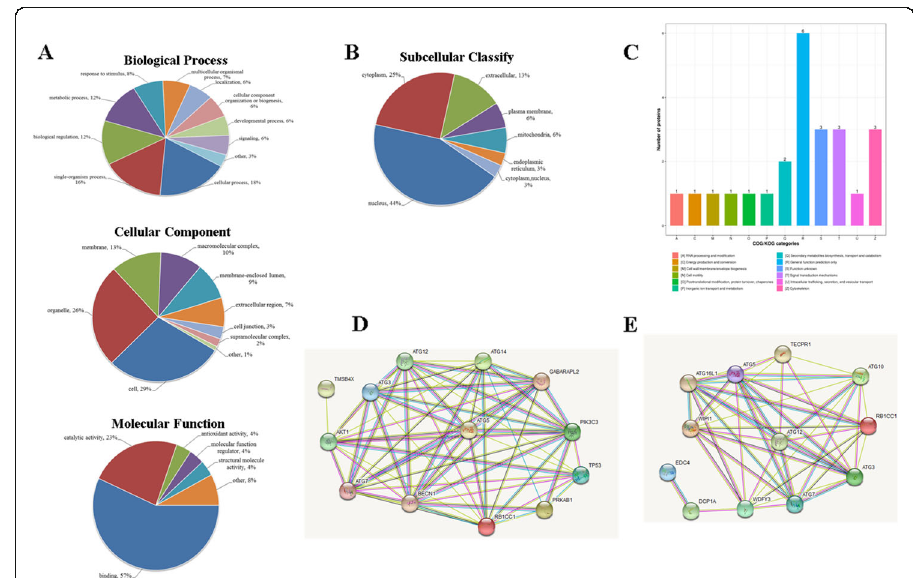
Fig. 3 Differentially expressed proteins under the presence of AS-IV treatment in cervical cancer cells analyzed by Gene Ontology. a BPs, CCs, and MFs evaluated. b Subcellular localization and classification of differentially expressed proteins. c Clusters of orthologous group classification of differentially expressed proteins. d TMSB4X/Akt/Atg5/Atg12 pathway; e DCP1A/WDFY3/Atg12 pathway. Proteins are represented by colored spheres, and interaction proteins are represented by white spheres. The interactions already recorded in the database are shown with blue lines and the interactions that are confirmed by our results are shown in purple. Two adjacent genes are linked by green lines and gene fusion is shown with red